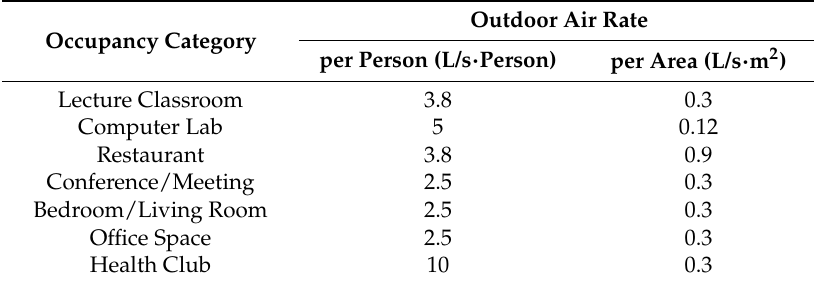
Table 1. Occupancy category vs. required ventilation